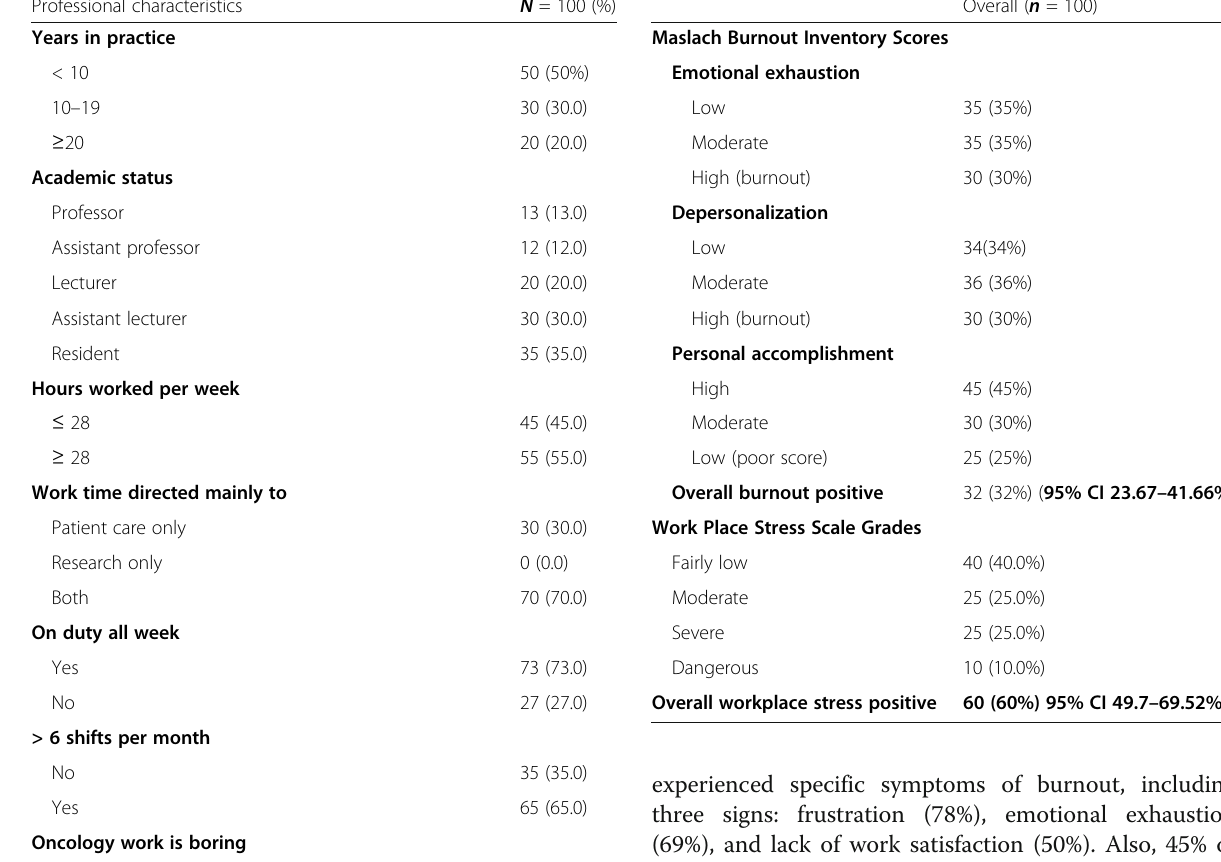
Table 2 Professional characteristics and working conditions of the studied oncologists Professional characteristics